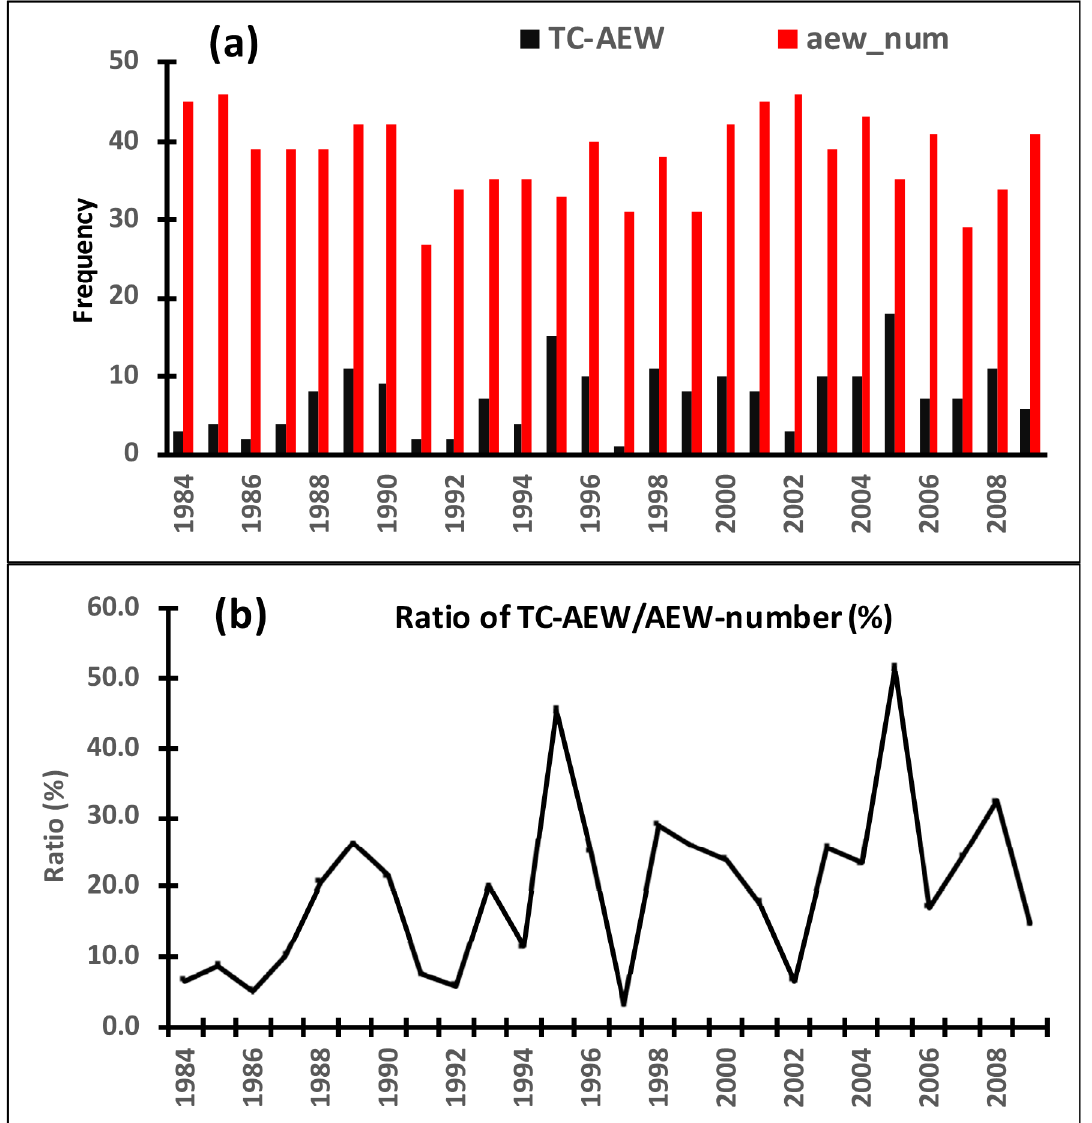
Figure 3. ( a ) The total number of AEWs (red bar) that crossed West Africa (20°–15° W) and named tropical cyclones spawned by AEWs (black bars). ( b ) The ratio (in percent) of named tropical cyclones spawned by AEWs and AEWs that crossed coastal West Africa.